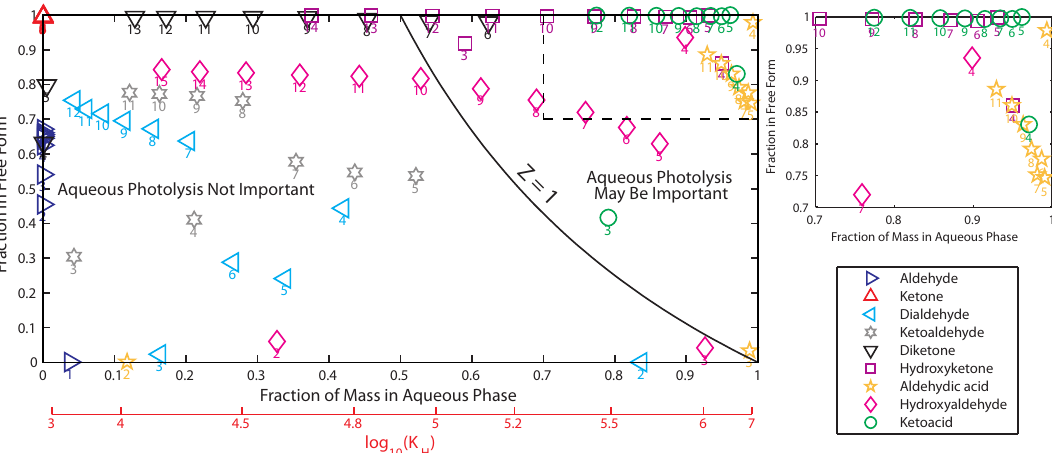
Fig. 2. Fraction of carbonyl compound in the aqueous phase at equilibrium as a function of the fraction of carbonyl compound in the free form for linear-chain compounds in an air mass with a liquid water content of 0.5gm − 3 . The logarithmic effective Henry’s law constant is shown as a secondary x axis in red. Numbers below the symbols indicate the total number of carbon atoms in the molecule. Hydration equilibrium constants and effective Henry’s law constants are obtained from experimental data or computational predictions as explained in the Sect. 2.2. Molecules to the left of the Z = 1 line have gaseous photolysis rates that exceed the aqueous photolysis rates. Molecules to the right of the Z = 1 line indicate that specified molecules may have aqueous photolysis rates that exceed gas-phase photolysis rates. The upper-right figure is an expanded version of the main figure with limits indicated by the black dashed